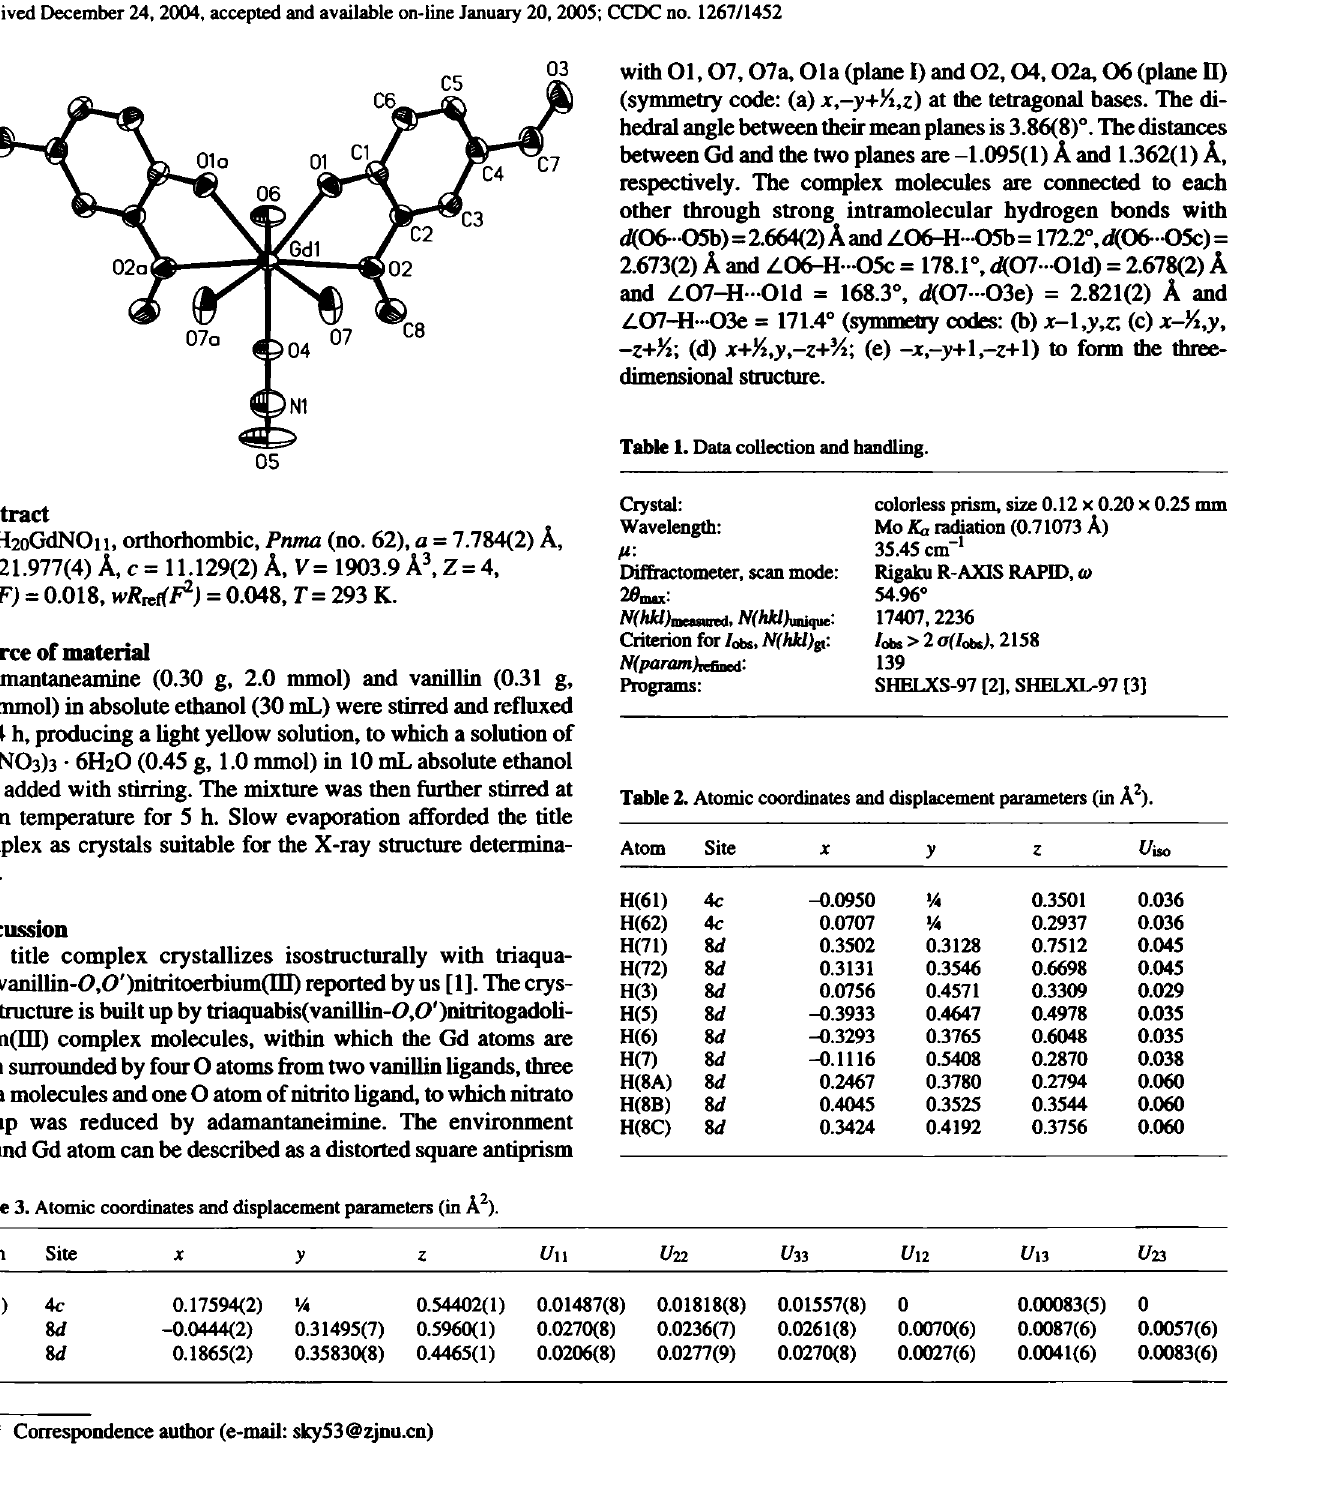
Table 3. Atomic coordinates and displacement parameters (in A 2 ).